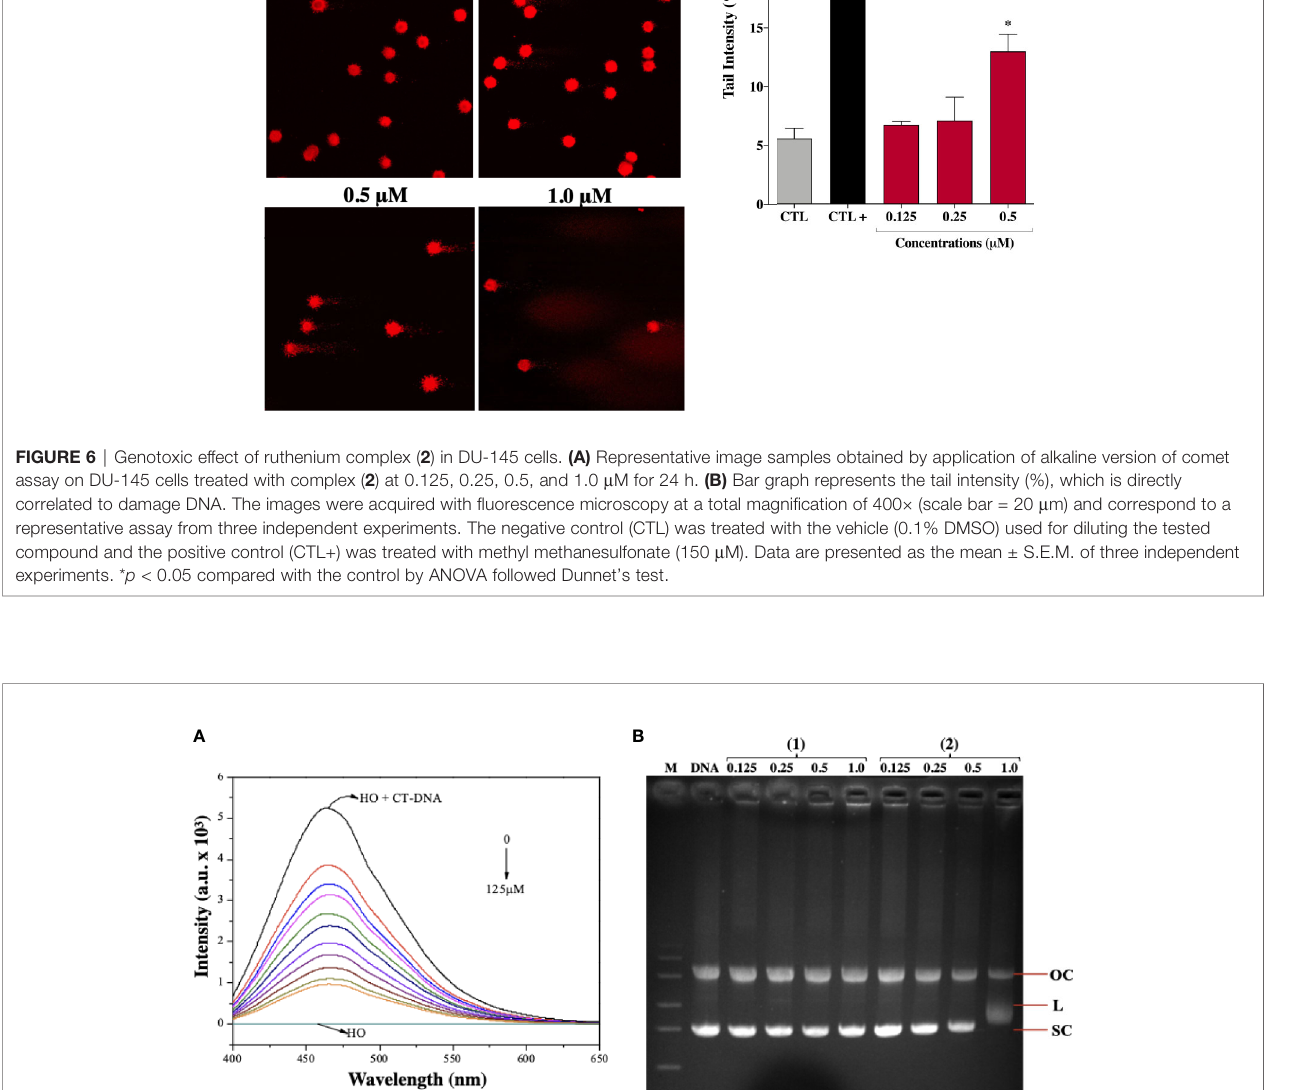
Frontiers in Oncology |